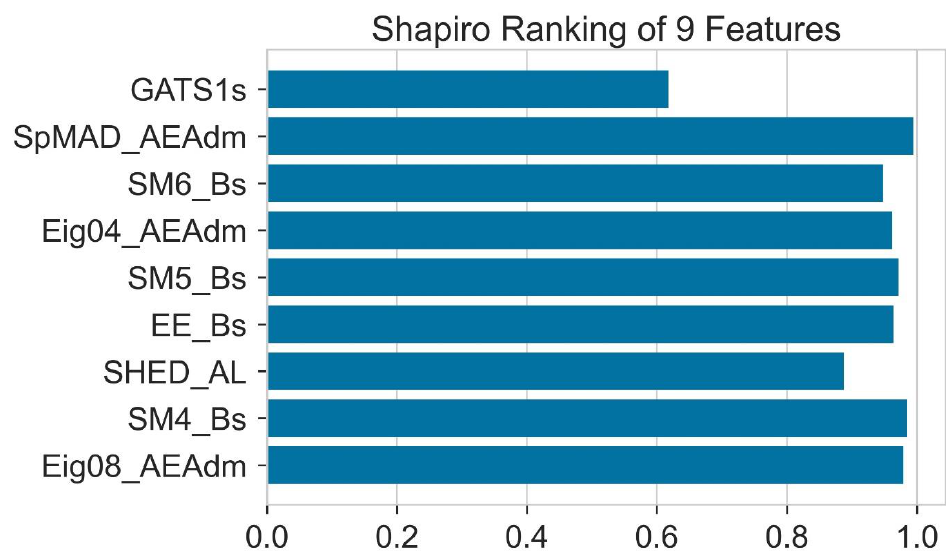
Figure 11. The normality of all the features analyzed by Shapiro test.